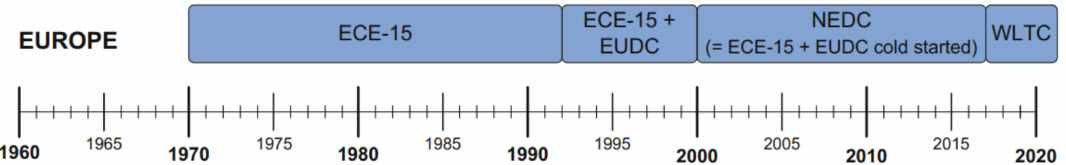
Figure 5. Timeline of test cycles used in Europe for tailpipe pollution TA.